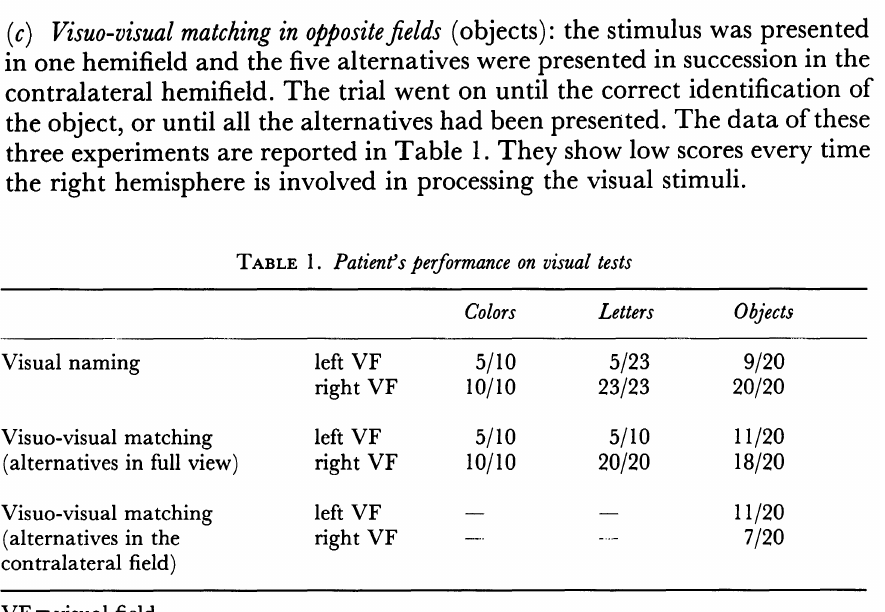
TABLE 1. Patienfs performance on visual tests